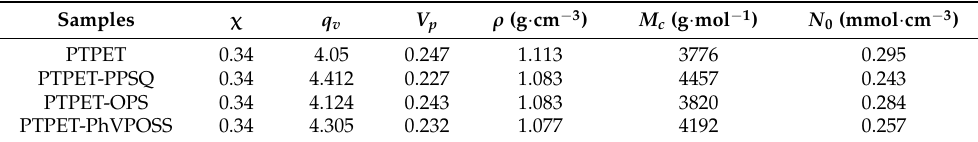
Figure 12. The volume swelling ratio ( q v ) ( A ) and apparent molecular weight ( Mc ) curves ( B ) of PTPET elastomer and composites. Table 4. Network parameters of PTPET elastomer and composites.